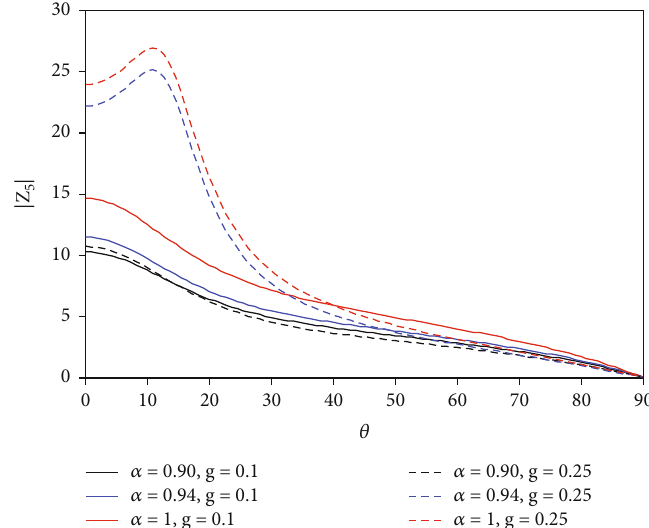
j concerning the angle of incidence θ for various values of the fractional parameter of the 5